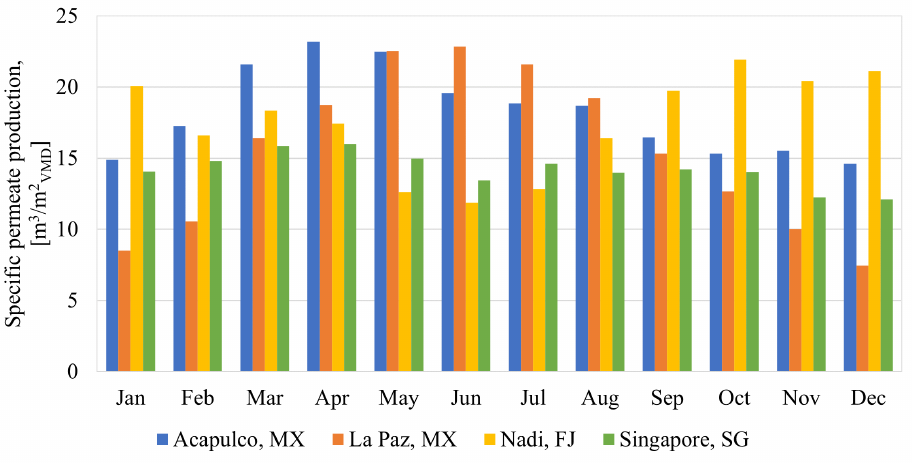
Figure 7. Monthly specific permeate production.